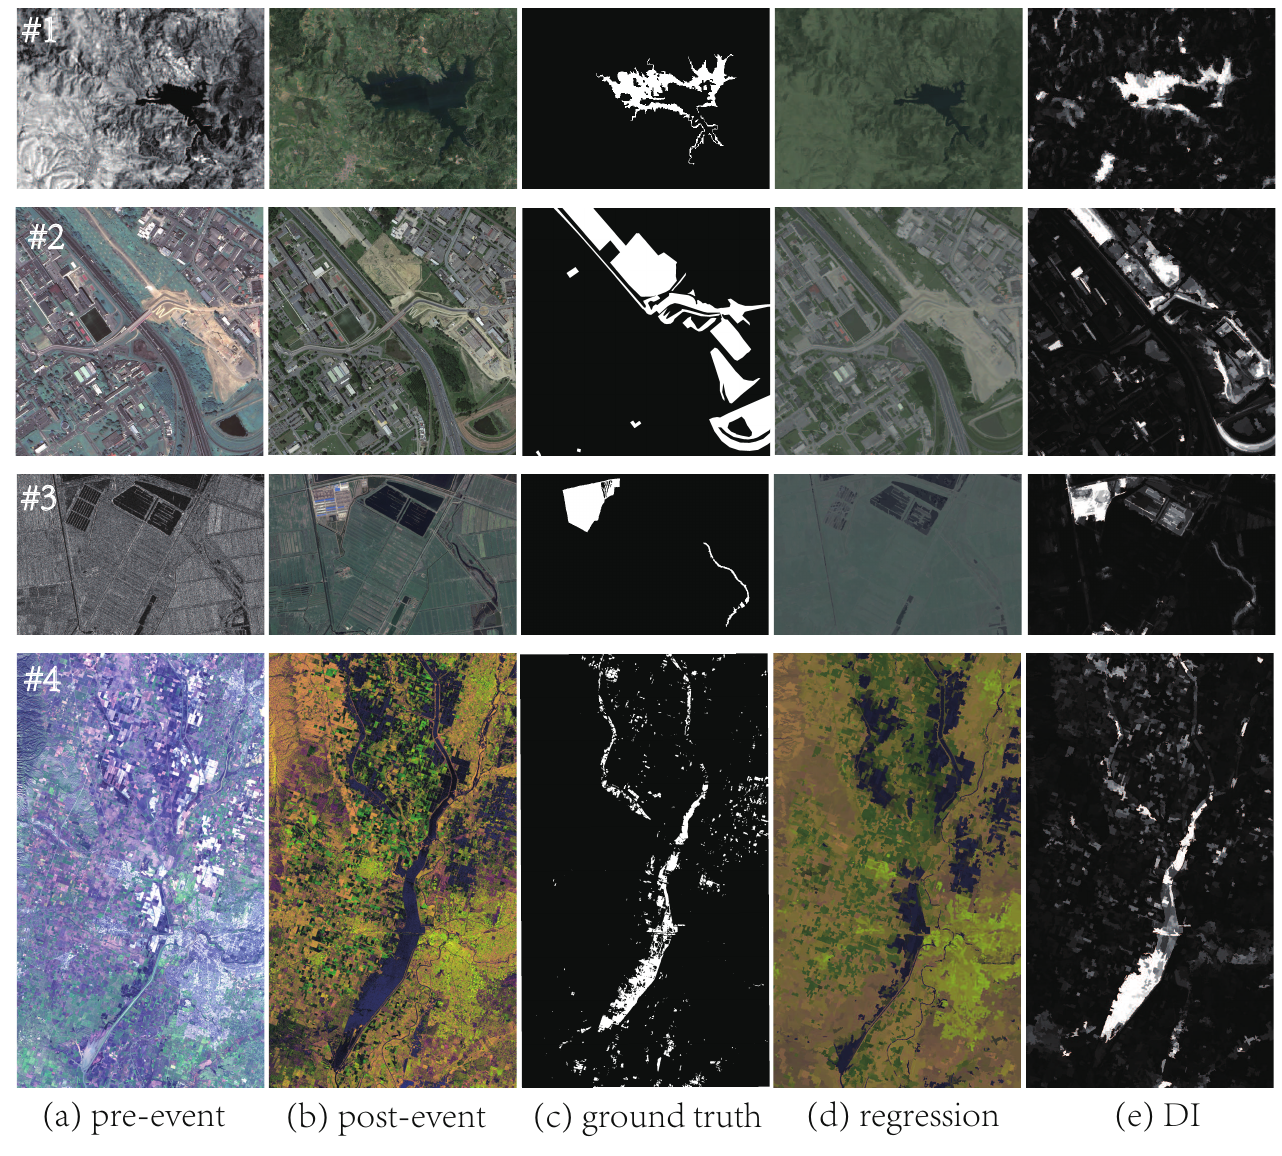
Figure 2. Heterogeneous datasets, regression images and DIs. From top to bottom, they correspond to Datasets #1 to #4, respectively. From left to right: ( a ) pre-event image ˜X ; ( b ) post-event image ˜Y ; ( c ) the ground truth; ( d ) the regression images ˜Z ; ( e ) the DI calculated by using (33) with changed feature matrix ∆